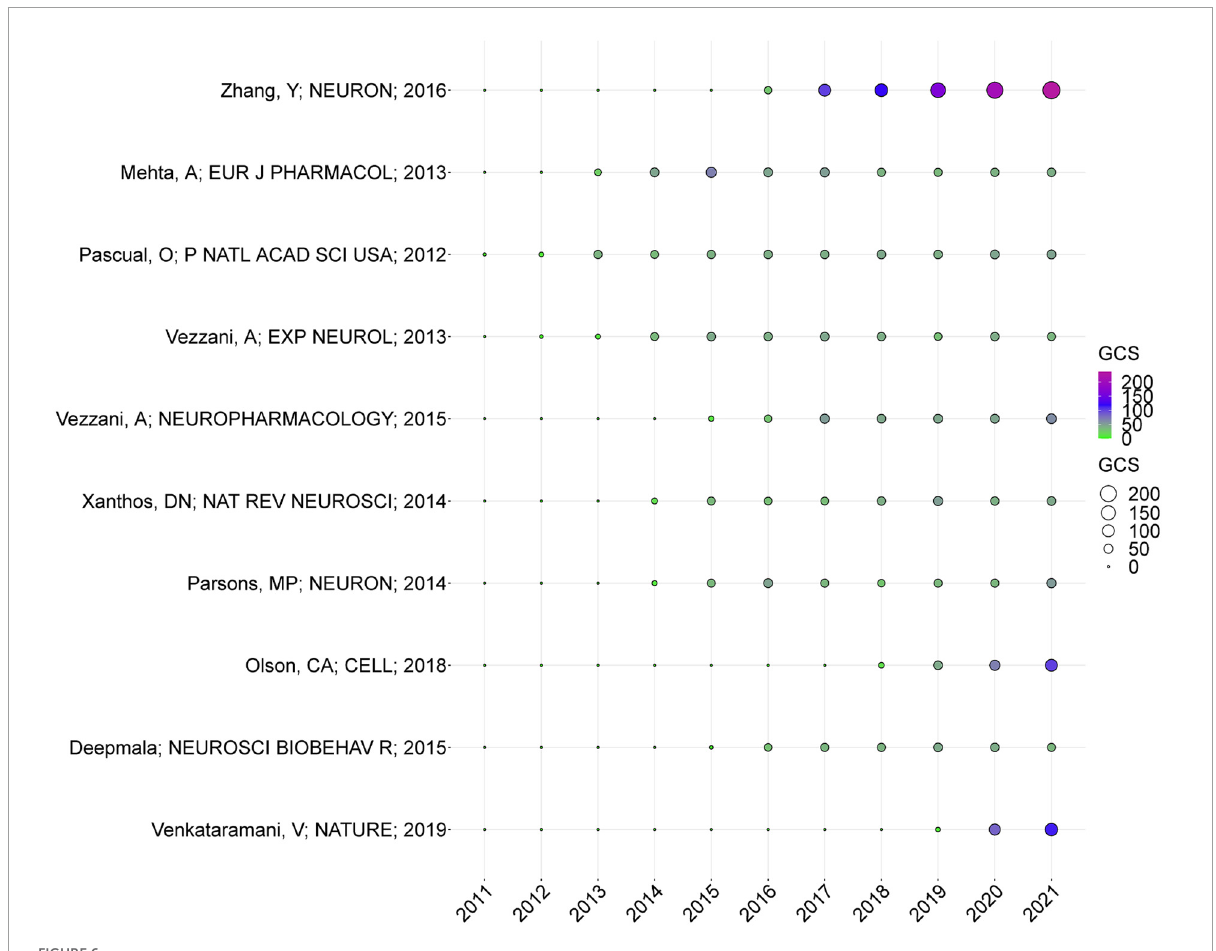
FIGURE6 Annual global citation score (GCS) of the top 10